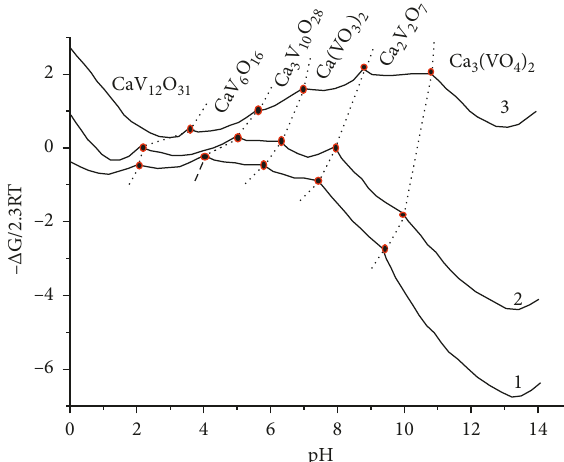
Figure 3: Δ G S versus pH for different CaO-V 2 O 5 -H 2 O systems: (1)